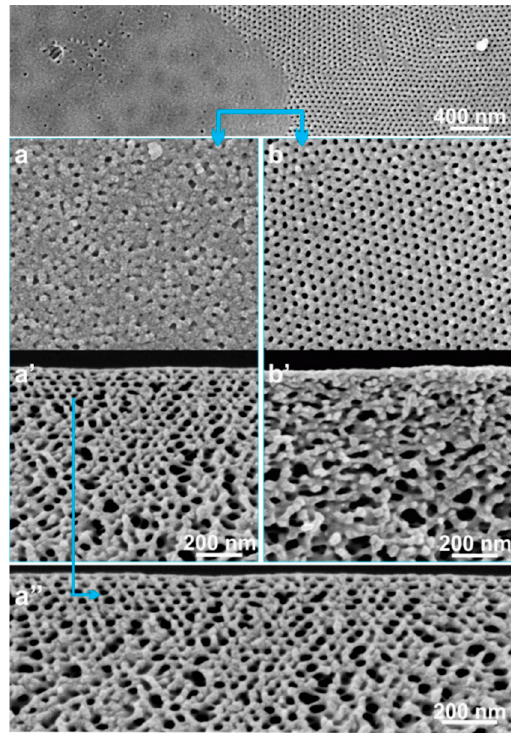
Figure 7. SEM micrographs of the surfaces of top ( a , b ) and cross-sections ( a’ , b’ , a’’ ) of the flat sheet cast using block copolymer solution of 18 wt% PS- b -P4VP 18150 in DMF / THF 1 / 1 (wt / wt). The casting parameters were Q g = 4.5 L/min and t g = 10 s.